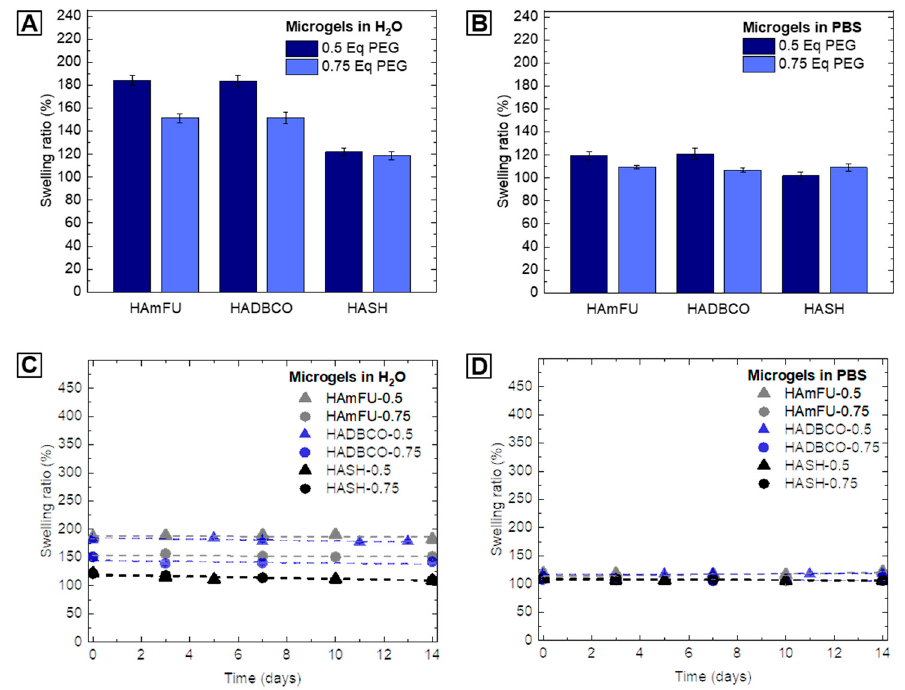
Figure 4. Swelling behavior and stability of HA-microgels in aqueous media. ( A , B ) Swelling ratio of HA-microgels in (A) water and (B) PBS related to the amount of PEG-crosslinker used for microgel formation (n = 100; mean ± SD). ( C , D ) Analysis of microgel stability in (C) water and (D) PBS over time (n = 50; mean ± SD). The swelling ratio is defined as the ratio between the average diameter of W/O emulsion droplets and the average diameter of obtained HA-microgels after purification.